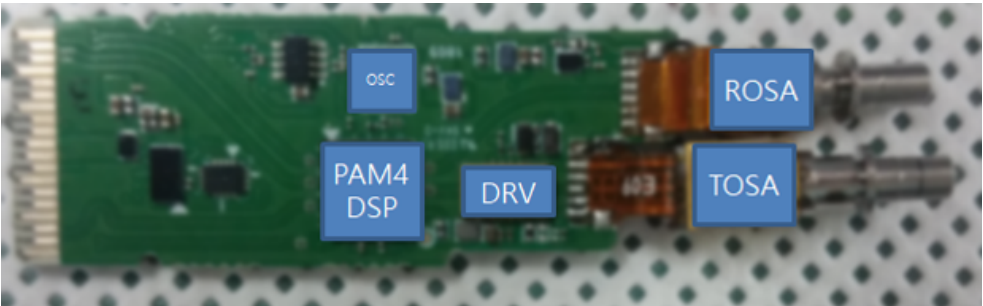
Figure 8. QSFP28 fabricated PCB with mounted parts.